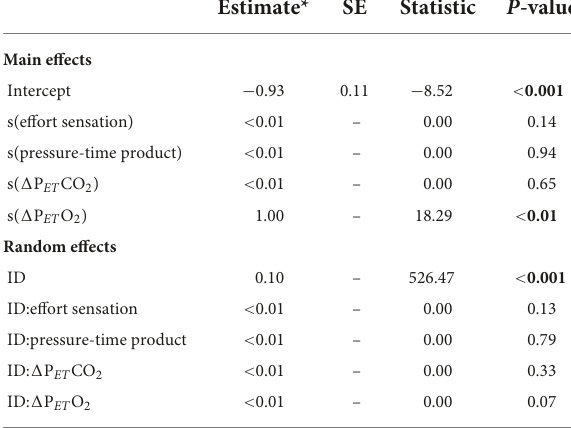
TABLE 2 Generalized additive mixed effects model (GAMM) results for overall median hit reaction time during inspiratory loaded trials.